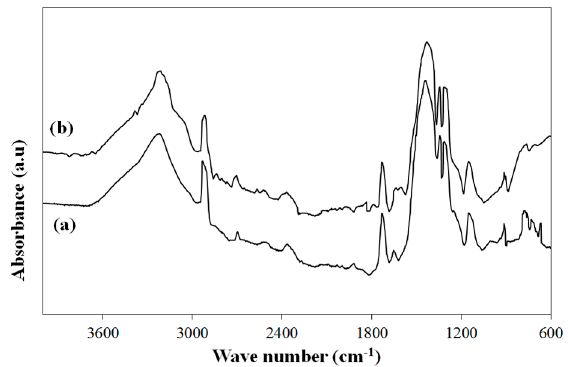
Figure 1. Fourier transform infrared spectroscopy (FTIR) spectra of ( a ) pure polyvinyl borate (PVB) and ( b ) PVB/TiO 2 (10 wt.%) composite.